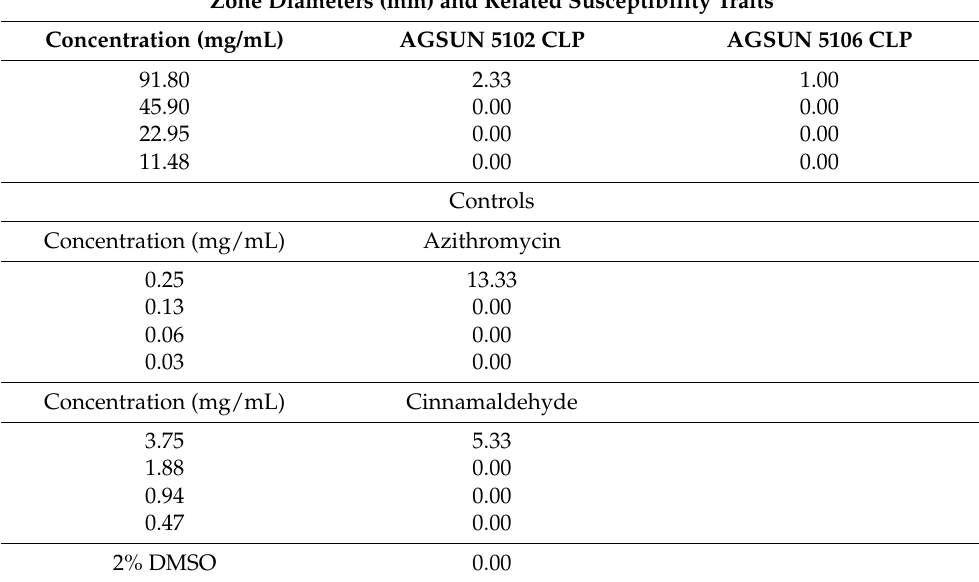
Table 2. Qualitative AQS activity of AGSUN 5102 CLP and AGSUN 5106 CLP essential oils